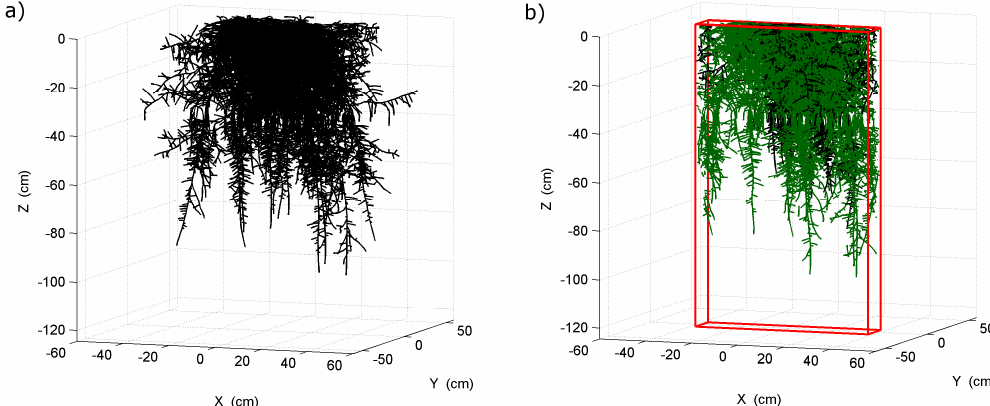
Fig. 2. Optimised 80-days old maize root system architecture (a) fully deployed and (b) in the periodic domain, green roots having crossed the domain boundaries (red). Figure 2. Optimized 80-days old maize root system architecture (a) fully deployed and (b) in 3 the periodic domain, green roots having crossed the domain boundaries (red). 4